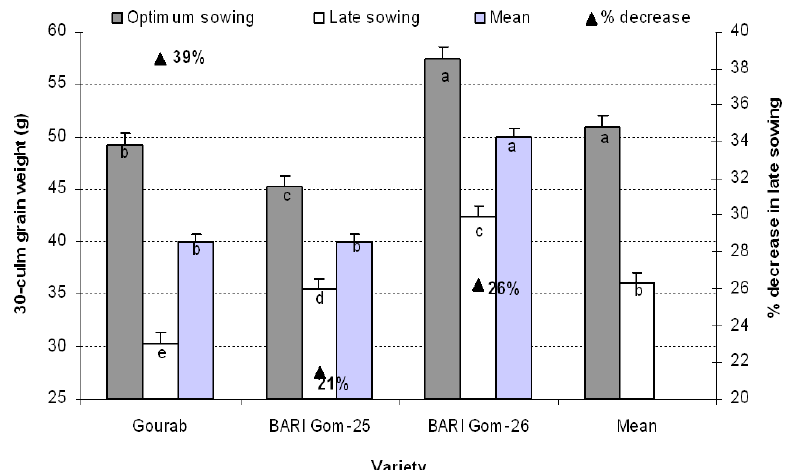
Fig. 10. Grain yield of 3 wheat varieties when sown under optimum and very late conditions. Mean (±SD) was calculated from three replicates for each treatment. Bars with different letters are significantly different at p ≤ 0.05 (LSD